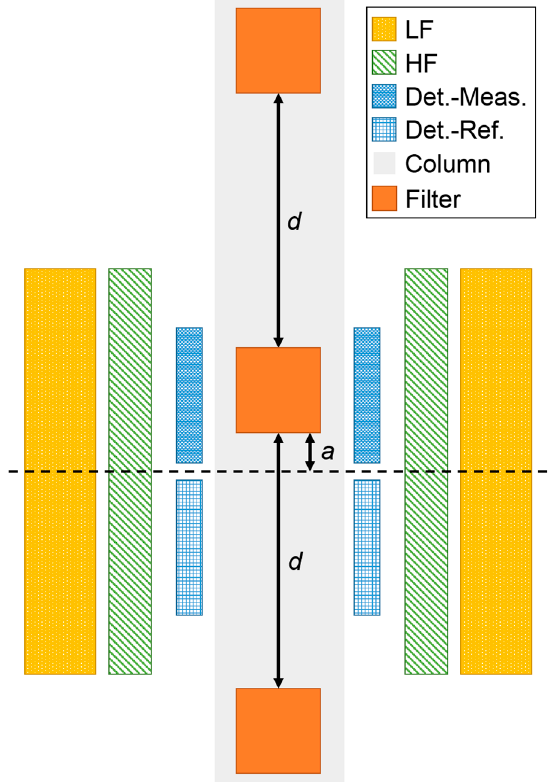
Figure 2. Schematic drawing of an axial cut through the multi-filter setup inside the measurement head. The measurement head consists of two coils for providing the oscillating low (LF yellow, dotted) and high (HF, green, diagonal lines) frequency magnetic field. The differential detection coil is shown with its two compartments for measurement (fine blue grid, top) and reference (blue grid, bottom). Three filters (orange) inside a column are shown. They have a distance d between each other. For the filter in the middle, the optimal distance a is indicated as well.